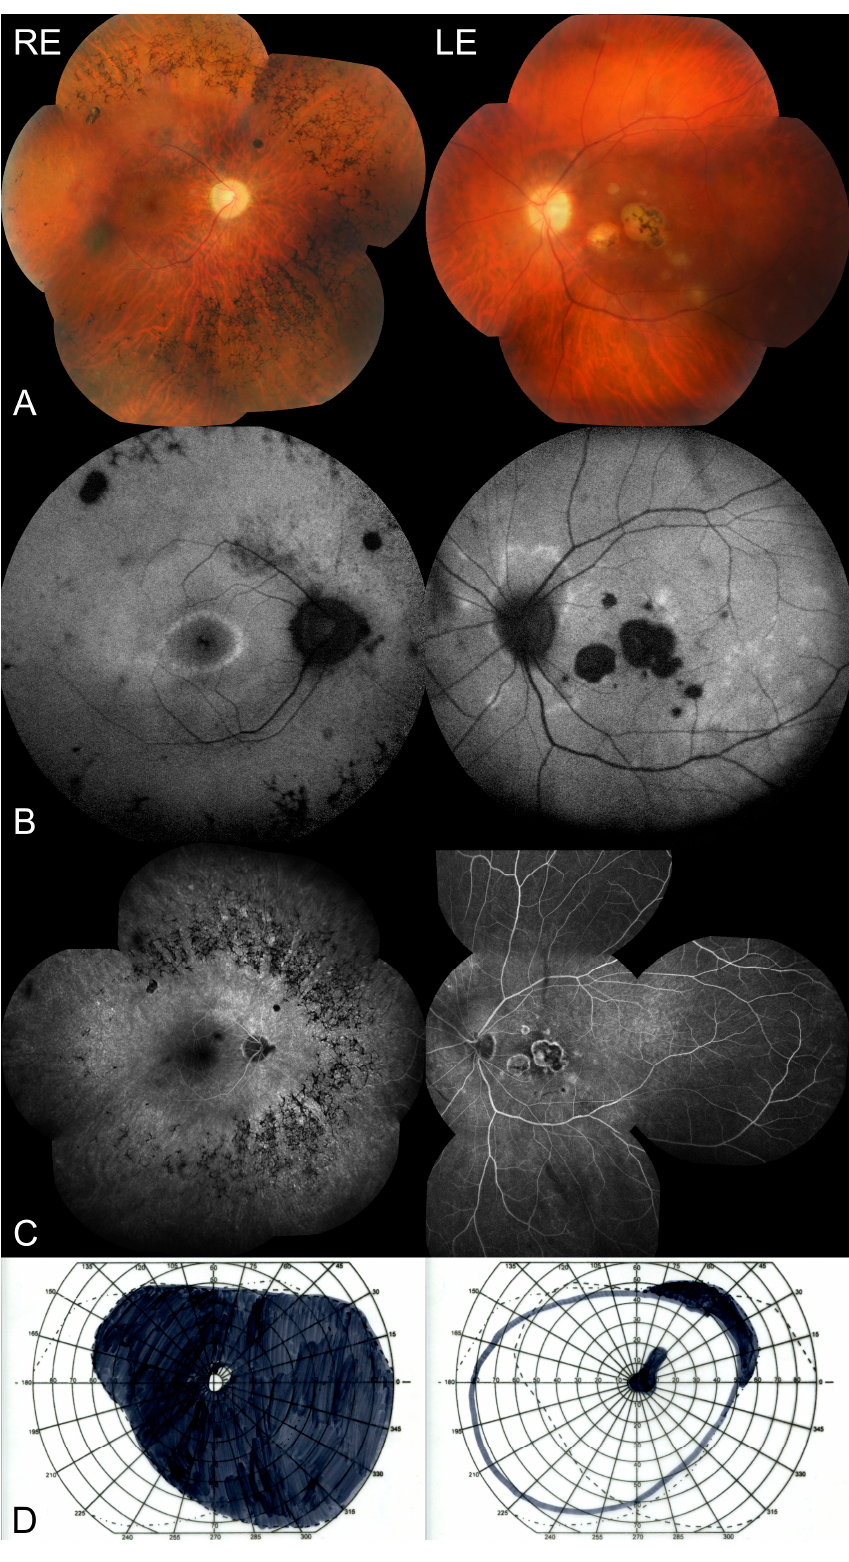
Figure 1. ( A ) Color fundus photography showing bone spicule-shaped pigment deposits, a slightly pale optic disc, arteriole constriction, and two small hyperpigmented chorioretinal scars in the RE, as well as an active inflammatory lesion at the border of the pre-existing chorioretinal scar in the macula in the LE. ( B ) Fundus autofluorescence showing hypoautofluorescence due to bone spicule-shaped pigment deposits and two small oval scars in the RE; central hypoautofluorescence with satellite spots in the macula of the LE. ( C ) Fluorescein angiography showing patchy hypofluorescence due to bone spicule-shaped pigment deposits in the periphery of the RE, as well as hypofluorescence in